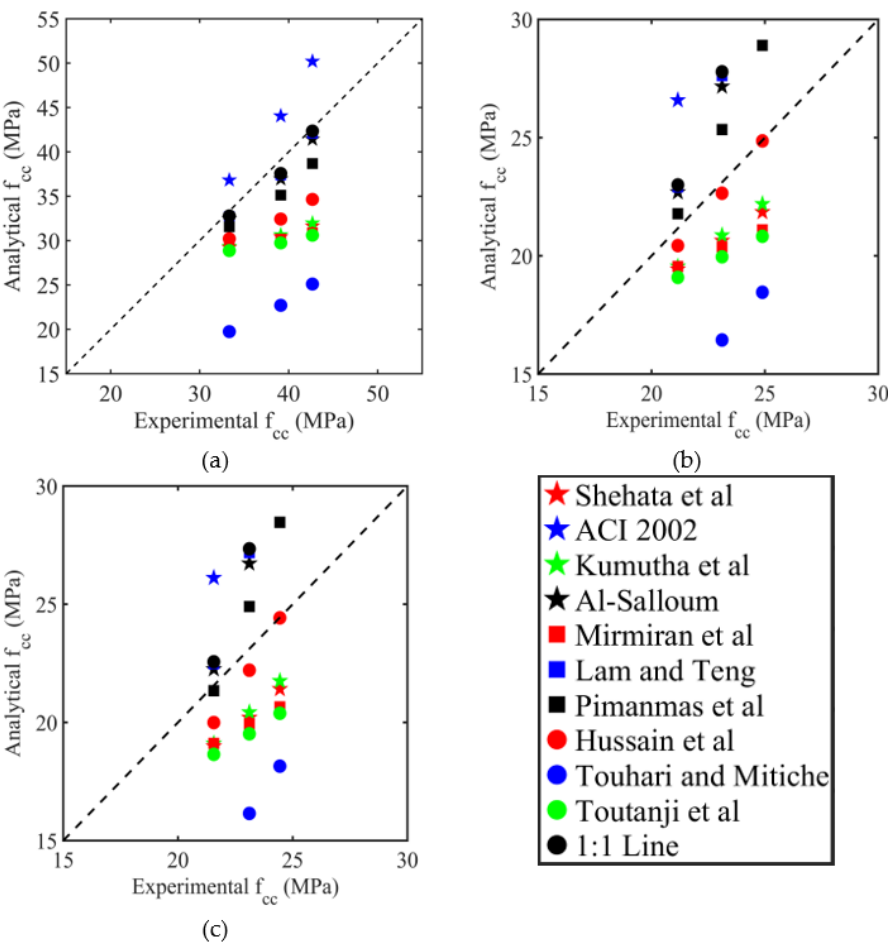
Figure 9. Comparison of the experimental and analytical results for the ultimate strength of specimens in ( a ) group 1, ( b ) group 2, and ( c ) group 3.